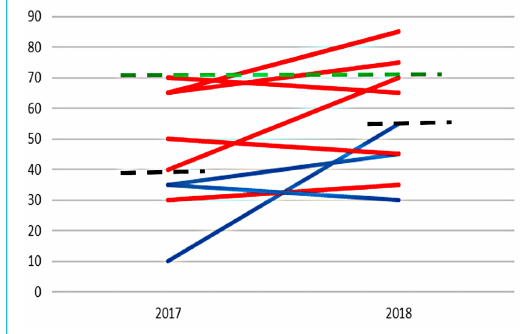
Figure 1: The diabetes score per practice before (2017) and after (2018) the criteria for good disease management of diabetes were implemented. Blue lines: group practices; red lines: single prac- tices; black dashed line: median score; green dashed line: the rec- ommended minimum diabetes score (70/100) suggested by the working group of the Swiss Society of Endocrinology and Diabetol- ogy. In six health facilities the score improved and in three prac- tices the score decreased slightly. Between 2017 and 2018 the